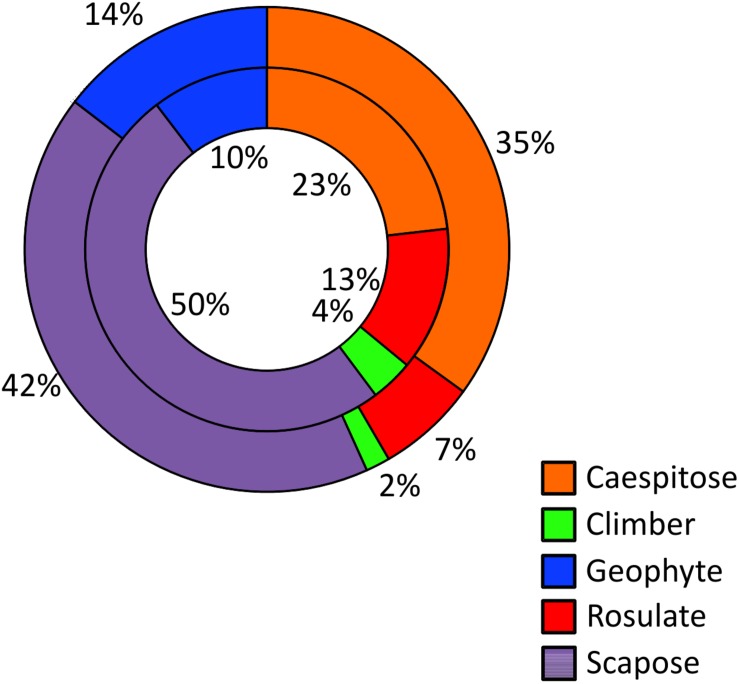
Frequency of the five commonest growth forms among NWFP (inner circle) and in the entire Sicilian vascular flora (outer circle).